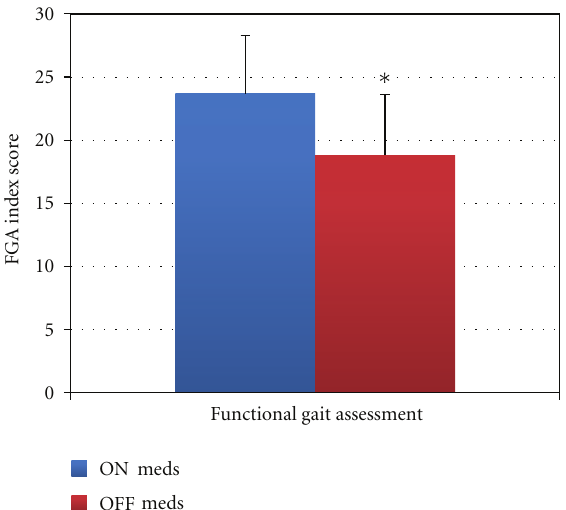
Figure 3: Clinical balance test results. ∗ P ≤ 0 .